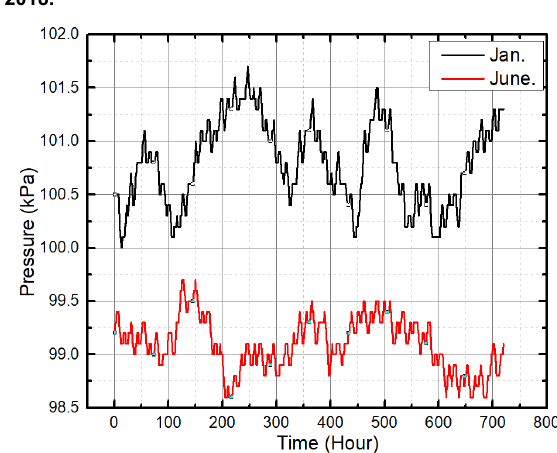
Figure 2. Atmospheric pressure measured near the ground; Dhahran